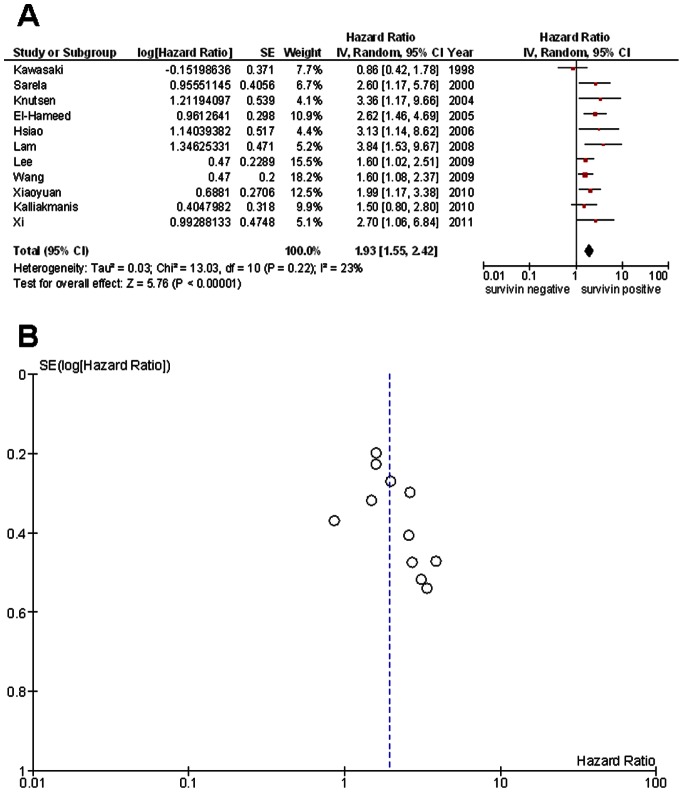
Meta-analysis comparing survivin expression and overall survival in CRC patients.(A) Forest blot reflects the individual and pooled HR with CI. Heterogeneity was calculated by the Cochrane Q test (Chi-squared test; Chi2) and by measuring the inconsistency (I2). (B) Funnel blot was designed to visualize a potential publication bias.